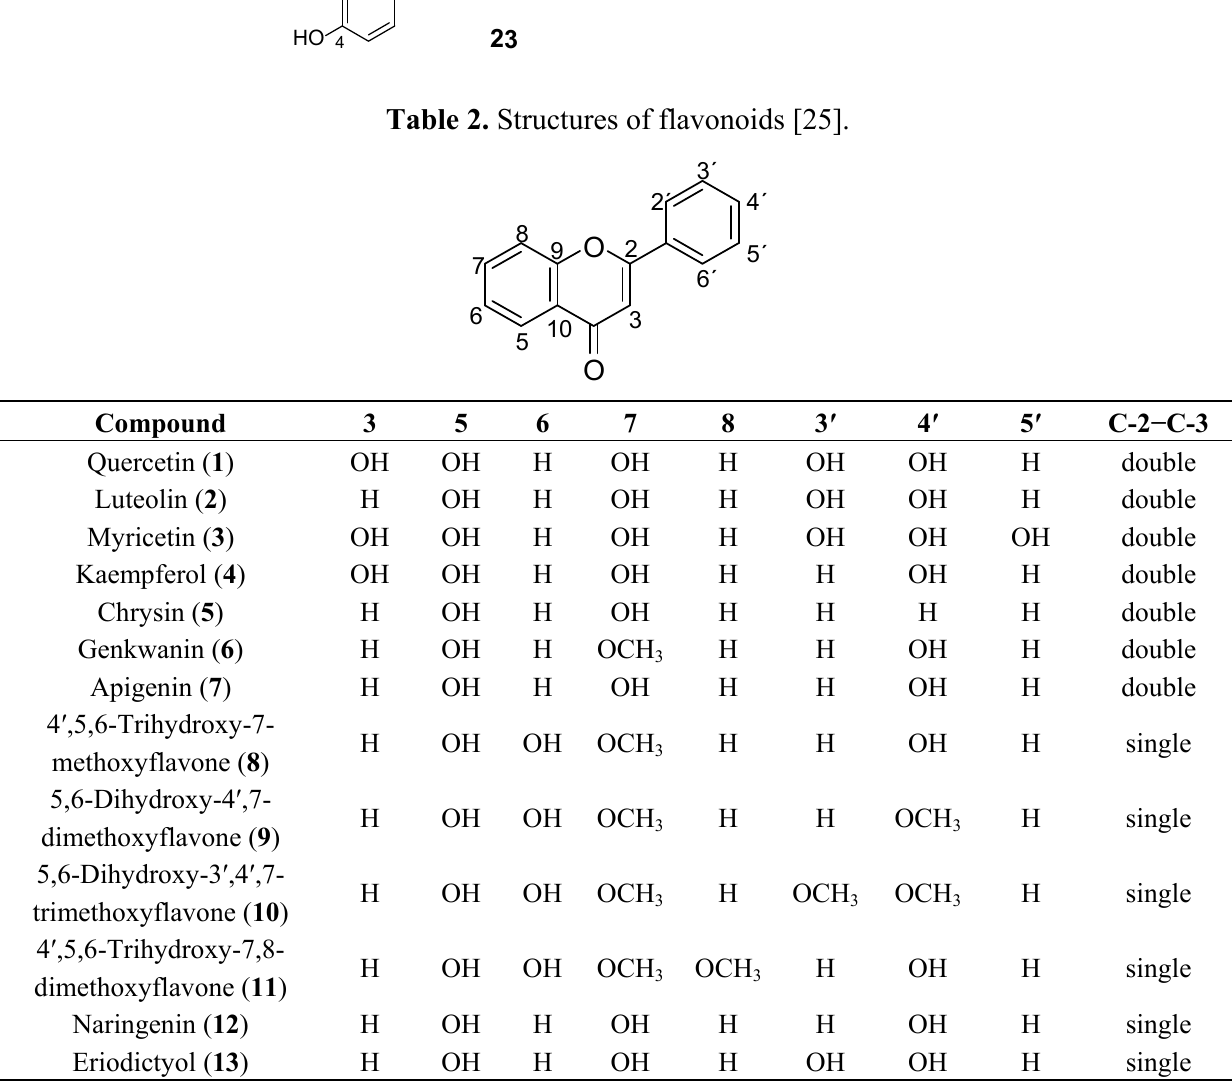
Table 2. Structures of flavonoids